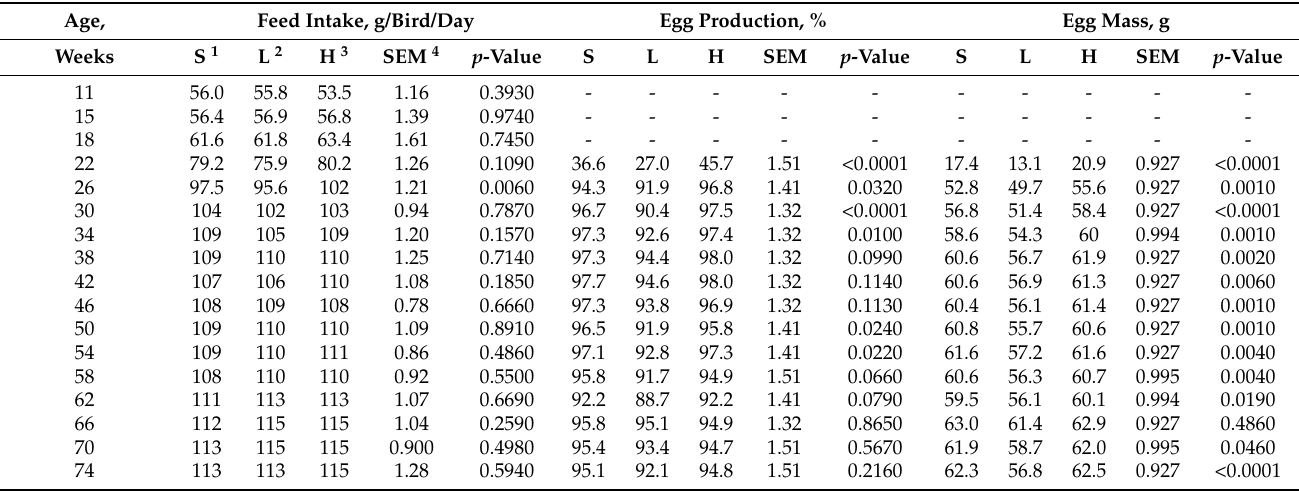
Table 4. Performance of laying hens from 8 to 102 weeks old in response to three dietary balanced protein